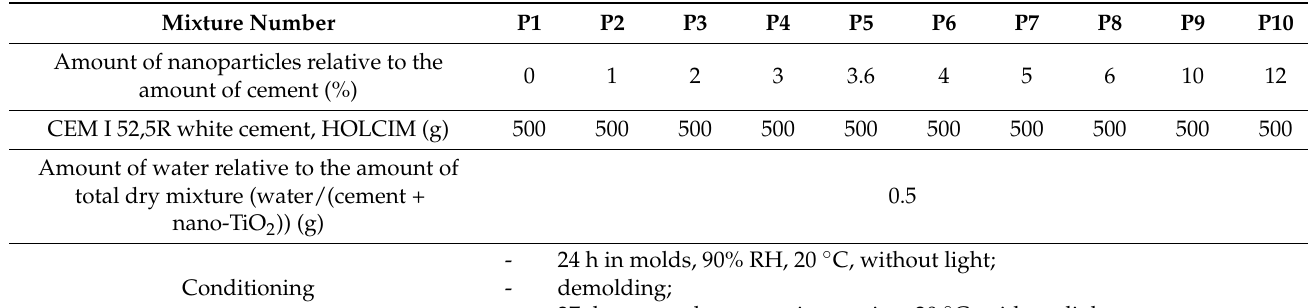
Table 1. Mix ratio and conditioning of cementitious composites.